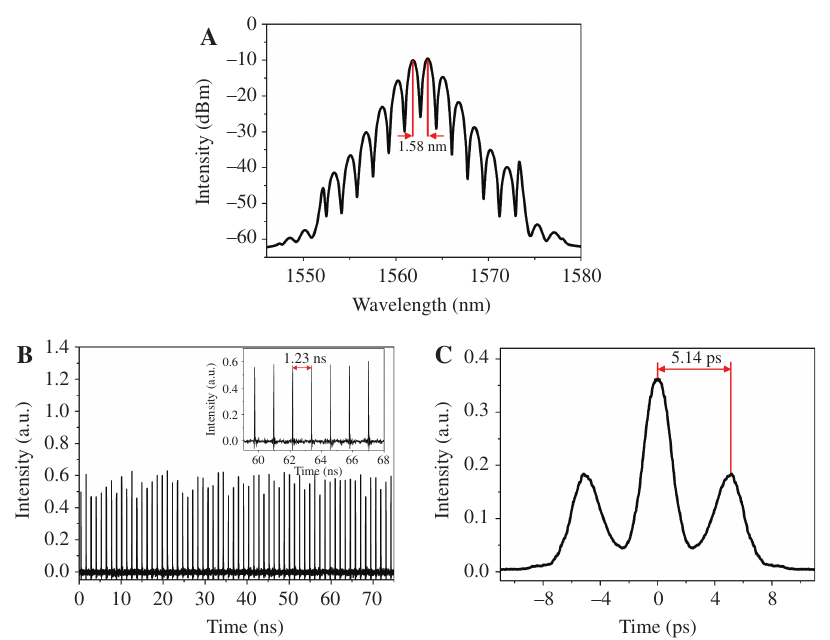
Figure 2: The bound-state harmonic mode-locking operation at a pump power of 105 mW. (A) the averaged spectrum; (B) pulse train; (C) auto-correlation